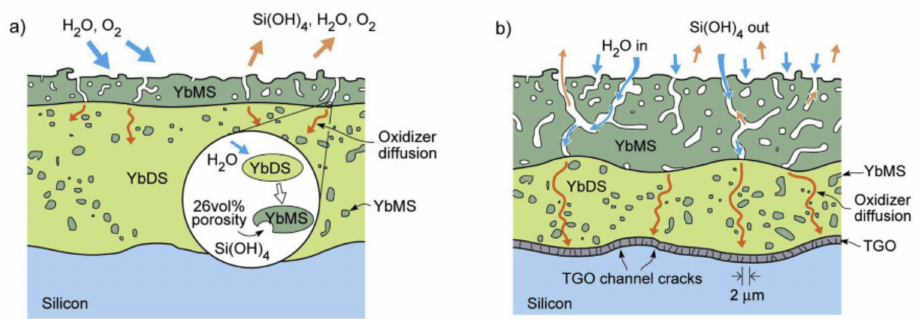
Figure 8. Schematic show of silica TGO volatilization and formation of porous ytterbium monosilicate layer (YbMS) on ytterbium disilicate (YbDS) surface, and TGO layer on silicon bond coat after steam cycling. ( a ) Early stage of volatilization, and ( b ) late stage exposure process, where microcracked TGO is presented